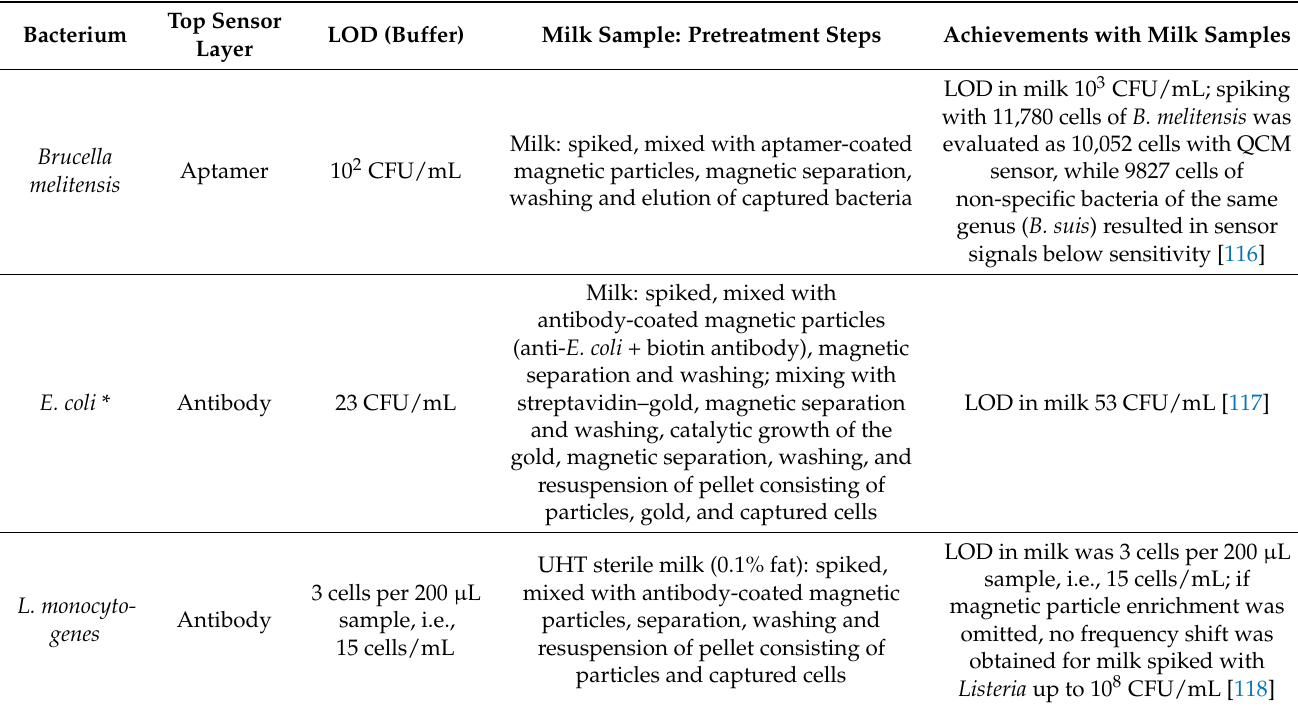
Table 5. Direct detection of pathogenic bacterial cells in cow’s milk with QCM sensors, after being separated with correspondingly coated magnetic